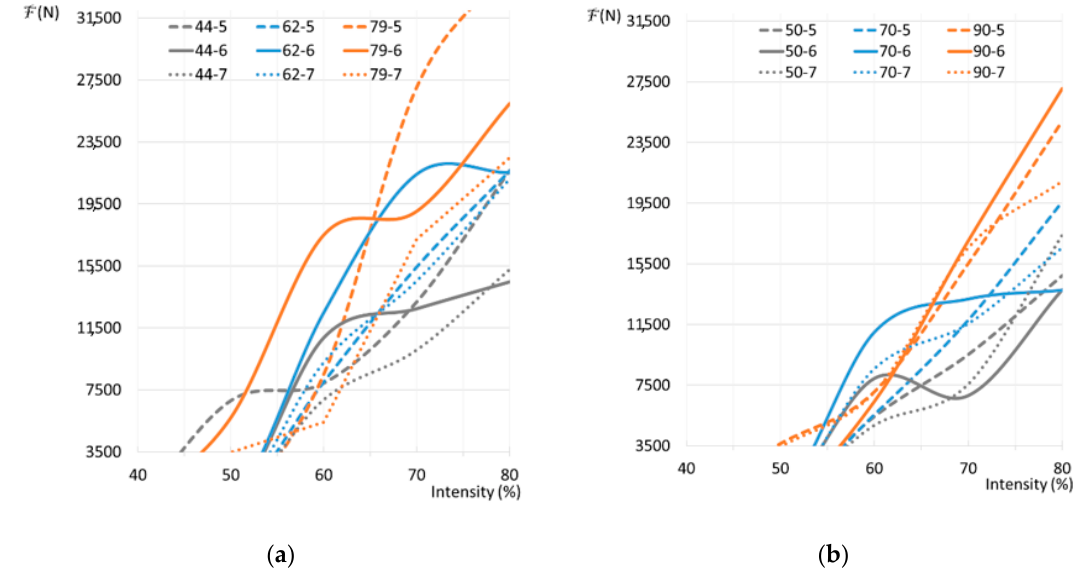
Figure 13. Force necessary for failure. Weld thickness: 28 mm ( a ) and 32 mm ( b ).